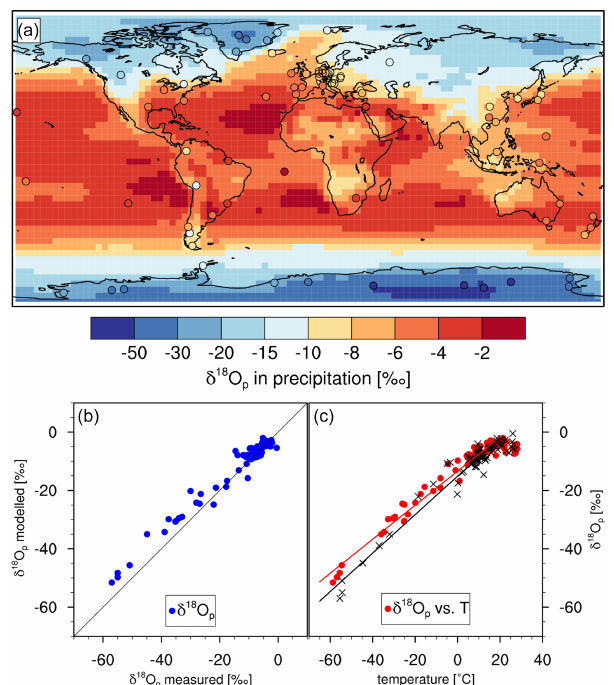
Figure 1. (a) Global distribution of simulated and observed an- nual mean δ 18 O p values in precipitation. The background pattern shows the δ 18 O p distribution as simulated by the ECHAM5/MPI- OM model set-up. Data from 70 GNIP stations (see text), from 21 ice core records (Table 1) and from 8 speleothem records (Ta- ble 2) are plotted as coloured symbols. (b) Modelled vs. observed annual mean δ 18 O p at the different GNIP, speleothem, and ice core sites. The black line represents the 1:1 line indicating a perfect model fit. (c) Observed (black crosses) and modelled (filled red cir- cles) spatial δ 18 O p – T relationship for annual mean values of T and δ 18 O p at 71 sites, where observed annual mean temperatures are below + 20 ◦ C. The black (red) solid line represents a linear fit of the observed (modelled) data